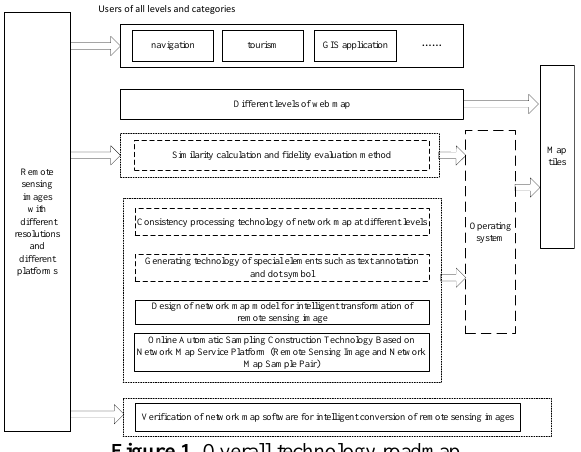
Figure 1 . Overall technology roadmap.